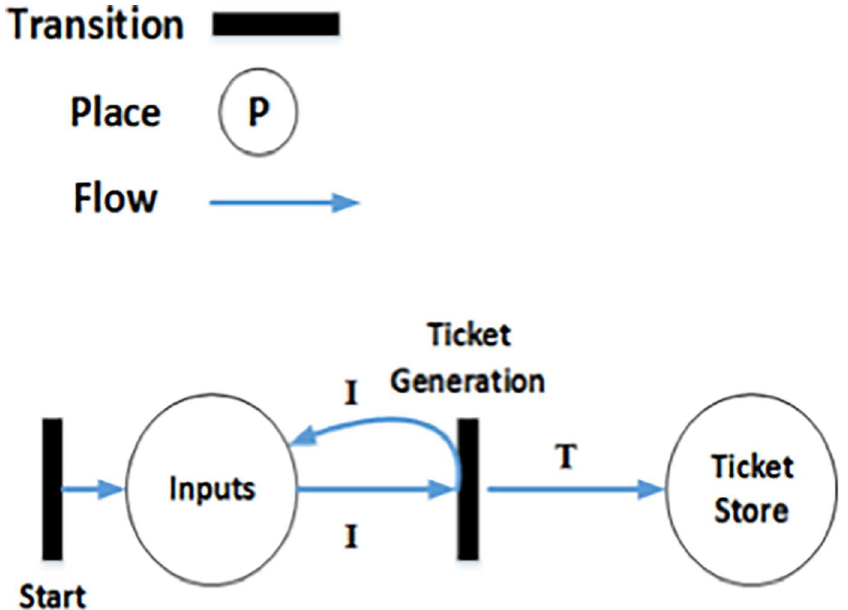
Fig 6. Algorithm 3: Generation of ticket (petrinet).